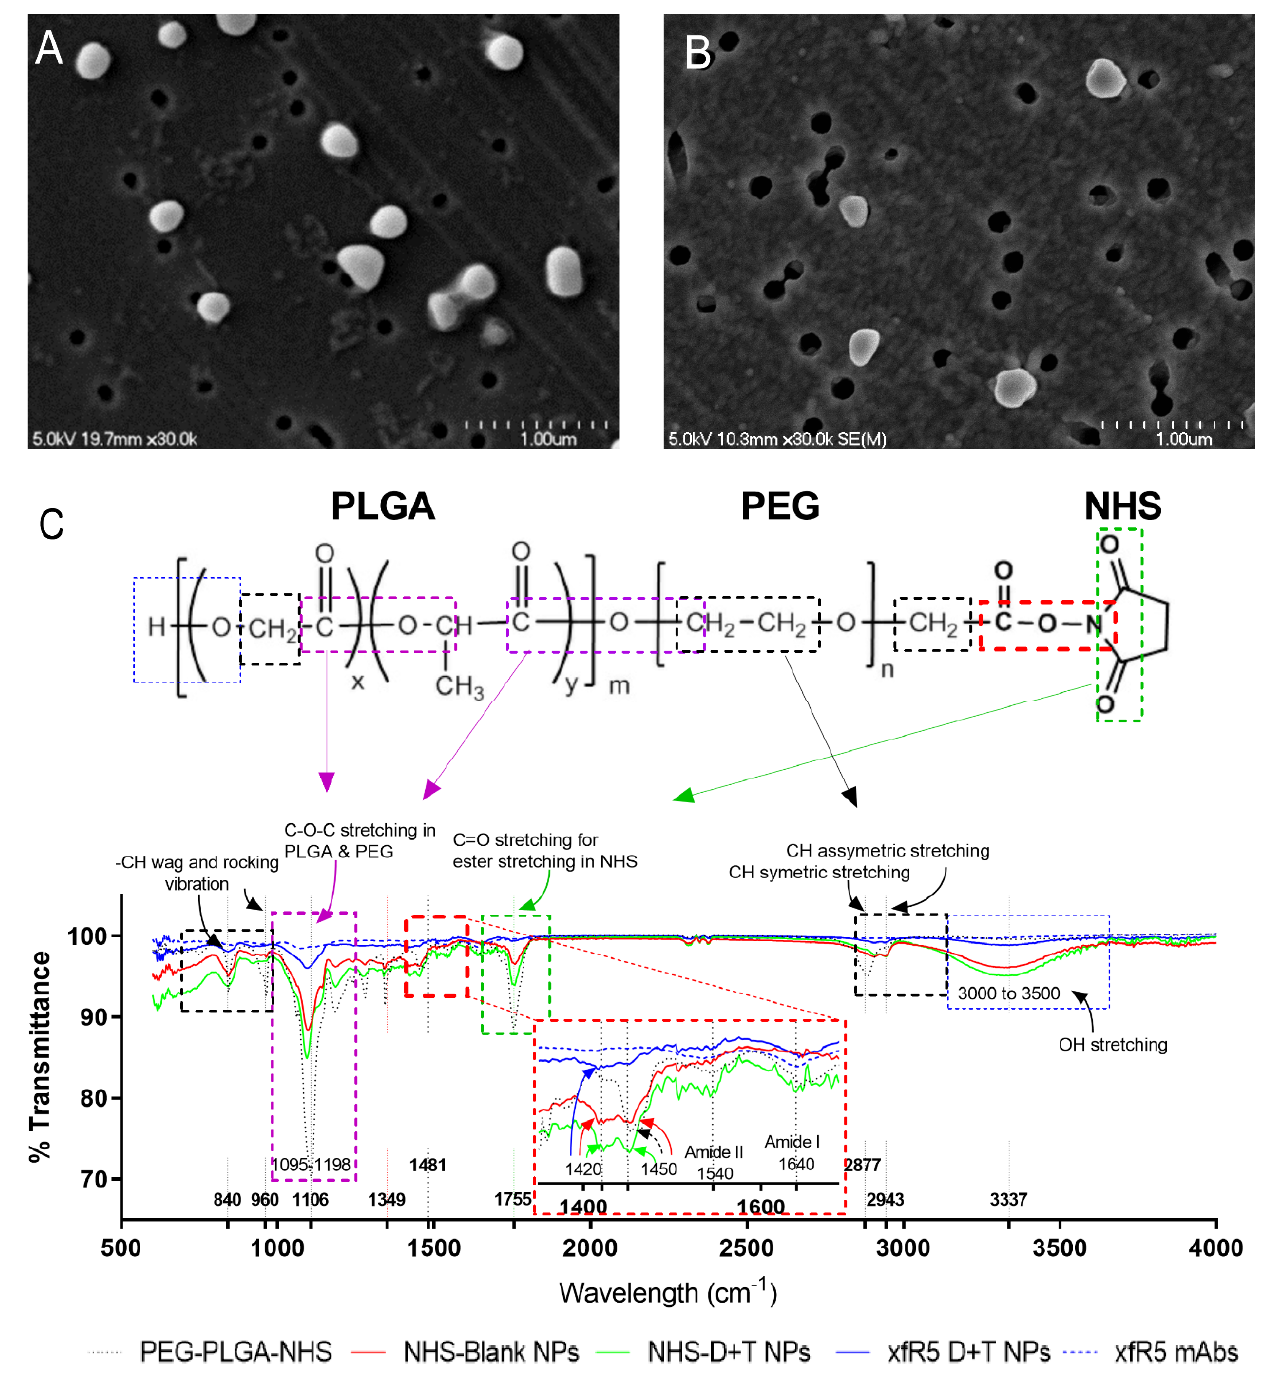
Figure 2. Representative scanning electron microscopic image of NHS-D+T NP ( A ) and xfR5 D+T NP ( B ). ( C ) Representative FT-IR spectrum obtained from PEG-PLGA-NHS polymer, NHS functionalized NPs (NHS-Blank NPs), NHS functionalized D+T NPs (NHS-D+T NPs), xfR5 D+T NPs, and xfR5 mAbs. The significant functional group bands are presented in various color boxes (Orange: –CH wag and rocking vibration band (840–900 cm − 1 ); Purple: C-O-C stretching bands (1095–1198 cm − 1 ); Red: amide bond; Green: C=O stretching band (1695–1818 cm − 1 ); Red: –CON– stretching based on reported FT-IR spectral studies [46,47]). Inset graph enlargement image ( C ) shows NH–band shifting from 1450 cm − 1 to 1420 cm − 1 indicating COO-NC bond conversion to amide bond (–CONH–); and the presence of Amide I and II at 1540 cm − 1 and 1640 cm − 1 , respectively.